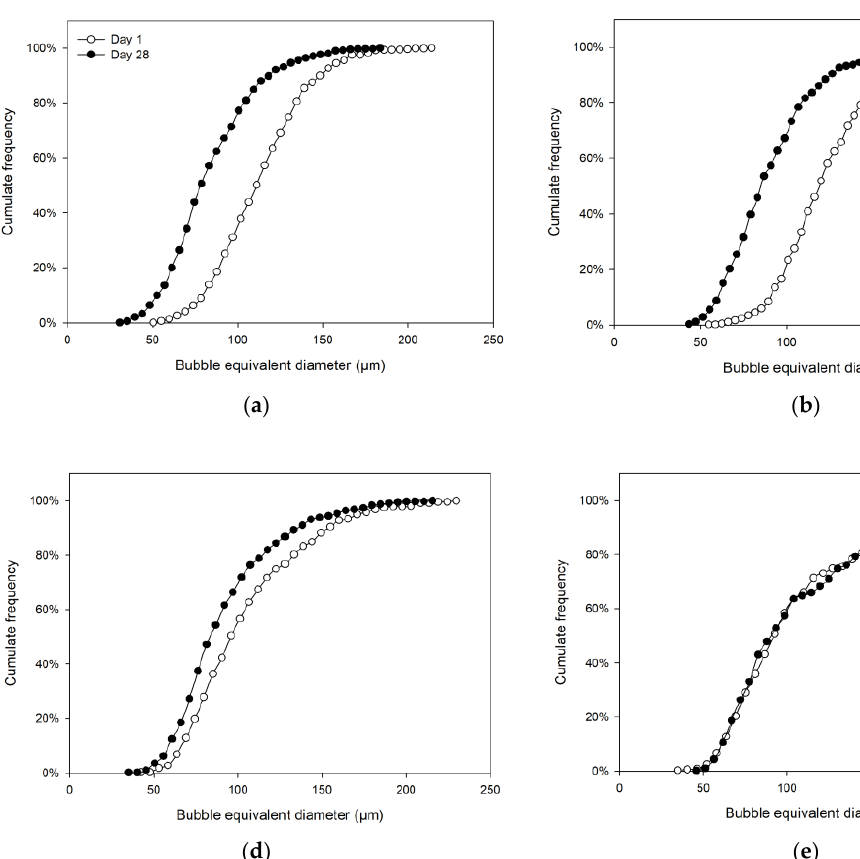
Figure 2. Optical microscopy (100×) of aerated CBJ–gelatin gels under different days of storage: ( a ) M1; ( b ) M2; ( c ) M3; ( d ) M4; ( e ) M5.